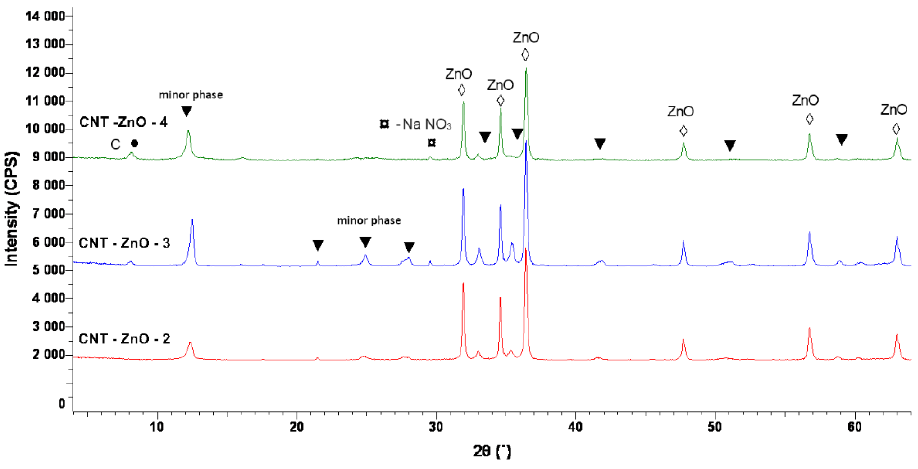
Figure 10. XRD spectra of CNT-ZnO-2 (1:10) — red; CNT-ZnO-3 (1:5) — blue, and CNT-ZnO-4 (1:4) — green nanocomposite samples.